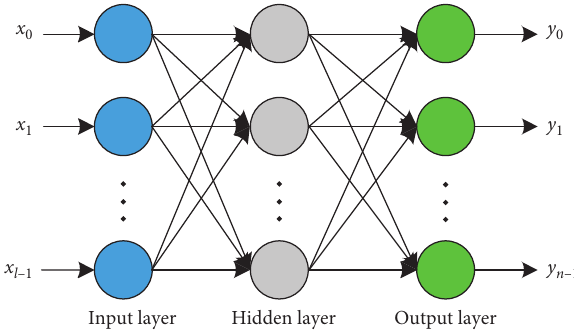
Figure 6: Typical BPNN